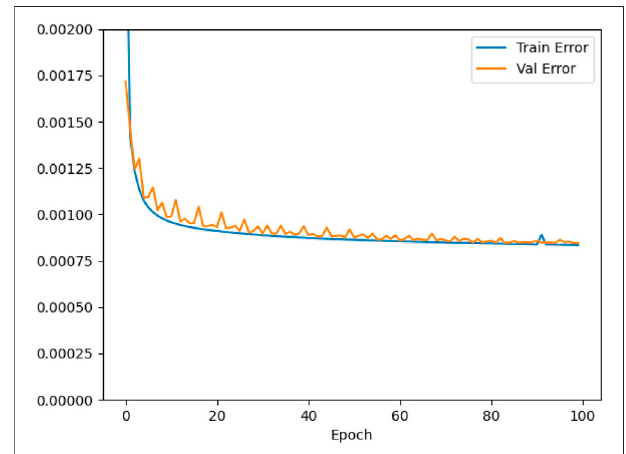
FIGURE 4 | Loss as a function of the number of